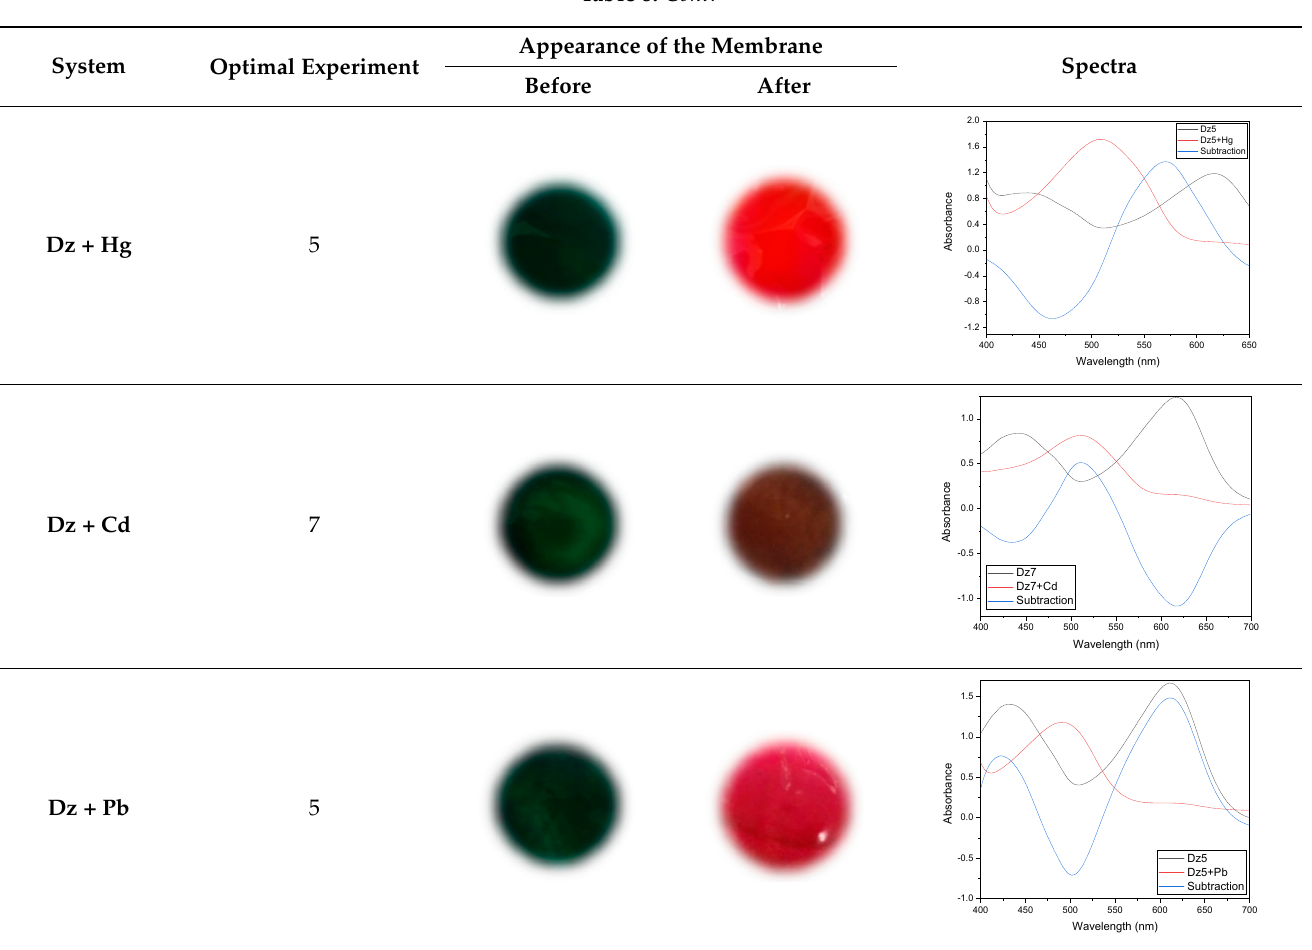
17 of 20 Table 8. Results for optimization using the PIM optodes and the M3 process method. System Optimal Ex- periment Appearance of the Membrane Spectra Before